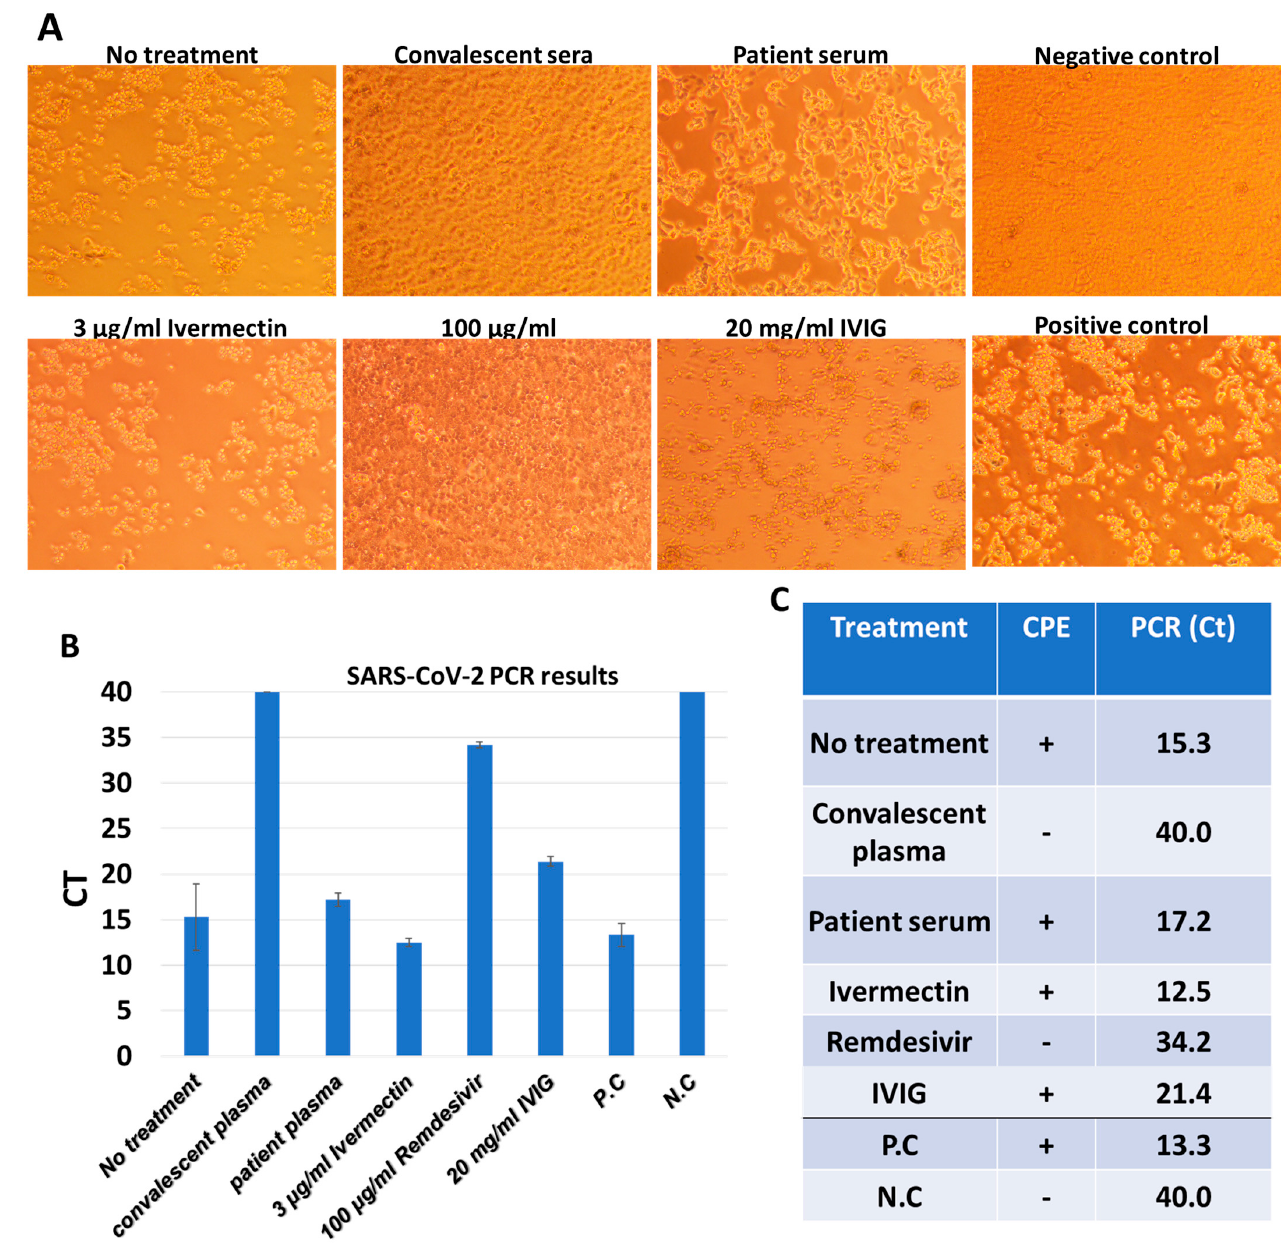
Figure 4. In vitro studies confirming that convalescent plasma and Remdesivir successfully eradicated the virus. ( A ): SARS-CoV-2 viruses (60 PFU/well) were treated with different agents in the presence of white blood cells from the immunodeficient patient. Each mixture was transferred to Vero E6 cells, followed by five days incubation to the formation of CPE. Representative images for each treatment are presented. ( B ): PCR results of SARS-CoV-2 identification from each treatment are presented (averages of three triplicates with their SD). P.C: positive control. N.C.: negative control. ( C ): Summary of CPE and PCR results for each treatment. +/ − presence/absence of CPE.